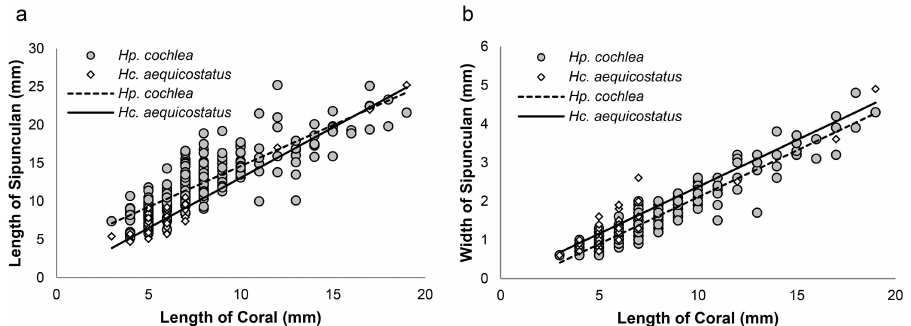
Fig 2. Relationships between corallum size and sipunculan size. Relationships betweencorallum length of the host corals and length (a) and width (b) of their symbiotic sipunculans in Heterocyathus aequicostatus and Heteropsammia cochlea